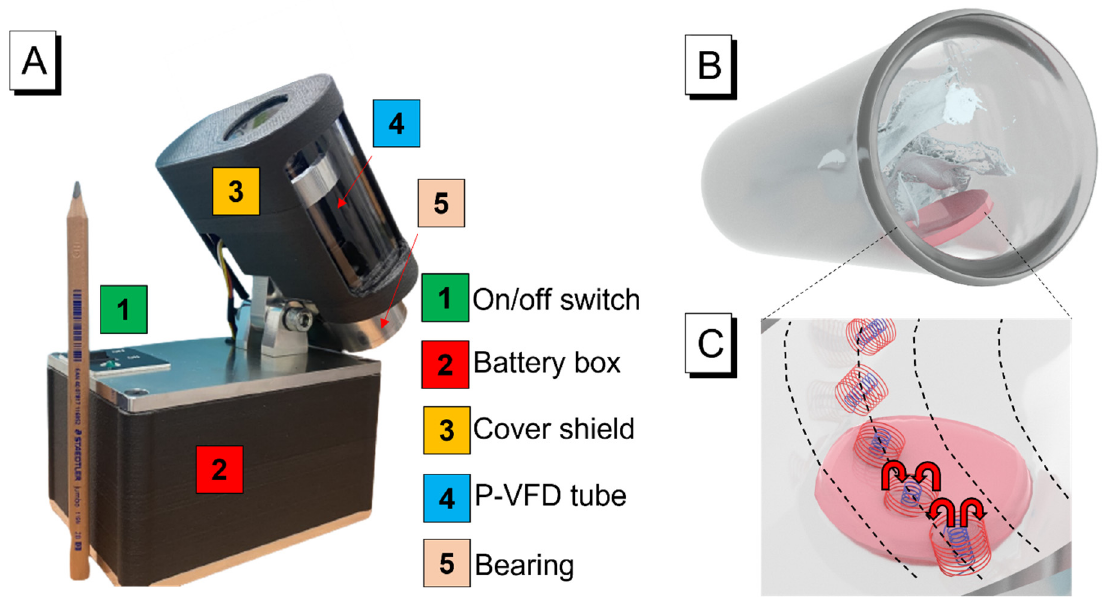
Figure 1. ( A ) Portable VFD used in this study; ( B ) interaction process between the solution and hydrogel film adhered to the tube wall; ( C ) efficient spinning top flow-mediated transfer of reactants into and out of the hydrogel matrix.